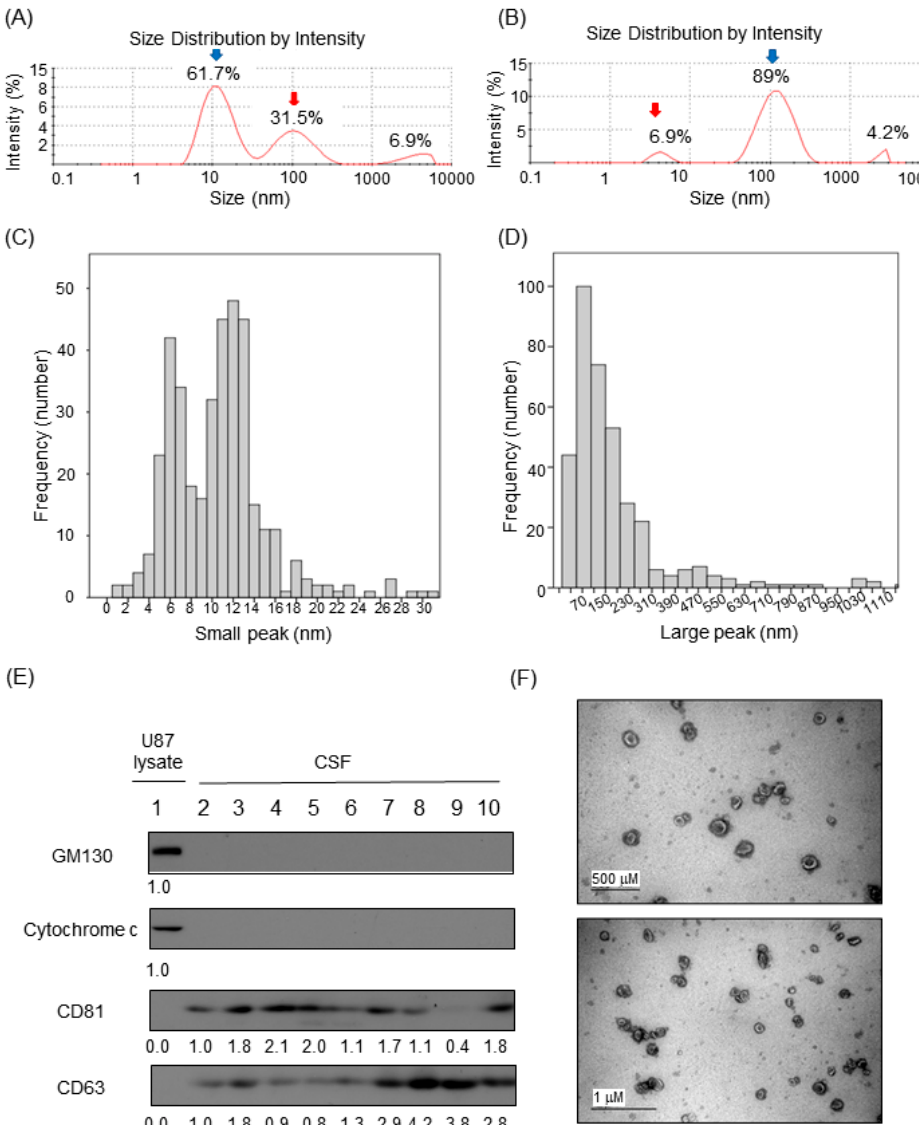
Figure 1. Identification of extracellular vesicle markers from CSF. ( A and B ) Representative diagram of observed peaks of nanoparticles in human cerebrospinal fluid by Dynamic Light Scattering (DLS) using the Zetasizer Nano system. ( A ) Healthy control and ( B ) leptomeningeal metastasis (LM). ( C and D ) Histogram depicting the two peaks in human CSF (n = 472) observed by Dynamic Light Scattering (DLS) using the Zetasizer Nano system. ( C ) The small peak was measured at a mean of 10.5 nm and ( D ) the large peak was observed at a mean of 176 nm. ( E ) Western blot of human CSF for exosomal markers. ( E ) Western blot of human CSF for exosomal markers. Golgi matrix protein of 130 kDa (GM130) and cytochrome c were used for the cytosolic organelle markers. U87 glioma cell extract was used as positive control. CD81 and CD63 were used for the exosomal membrane protein markers. Relative band intensities were written under each immunoblot. Samples in lane 2–6 were in LM group. Samples in lane 7–8 were in the brain metastasis (BM) group. Samples in lane 9–10 were in the other disease (OD) group. Relative band intensities were written under each immunoblot. Uncropped Western blots are shown in Supplementary Figure S8. ( F ) Transmission Electron Microscopy showing bi-membranous vesicles of purified CSF exosomes. scale bar; 500 nm (up), 1 μ m (down).